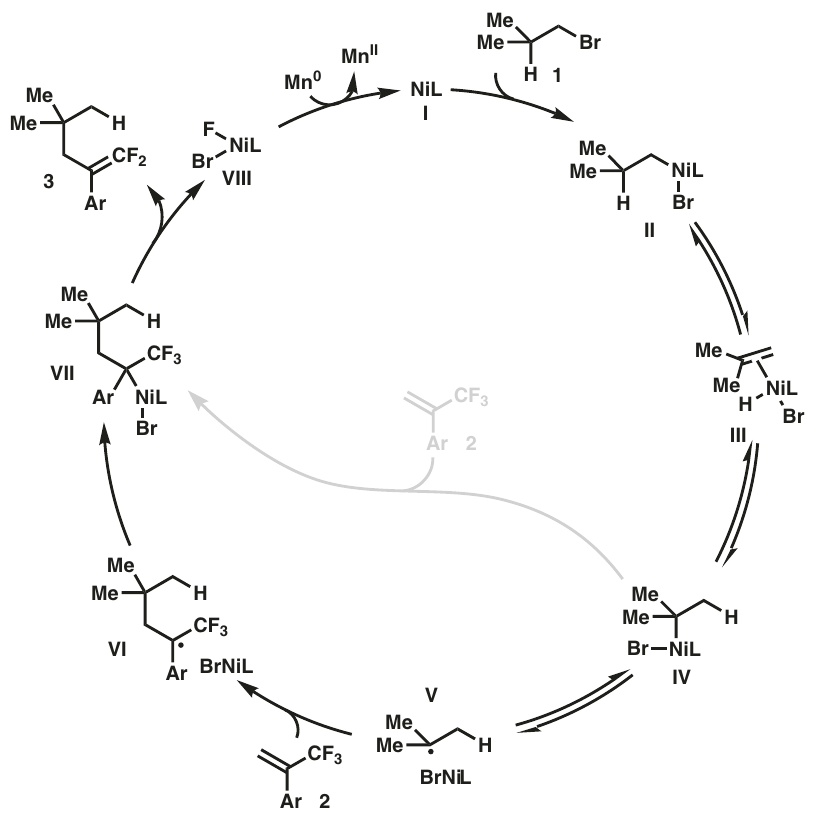
Fig. 3 Plausible mechanism. Ni-catalyzed chain-walking process enables a C-radical translocation event, thus allowing migratory functionalization at the sterically more hindered